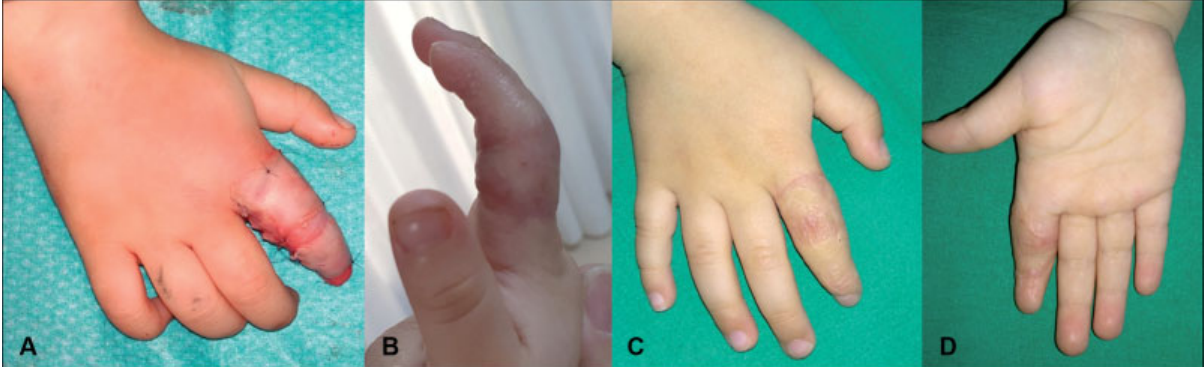
Fig. 2 Treatment of the sequelae. ( A ) Immediate postoperative result after surgical debridement of the burn on the dorsum of the fi nger and escharectomy of the ischemic eschar at the base and grafting with partial-thickness skin grafts. ( B ) Severe palmar contracture of the digit at 3 months follow-up. ( C ) Dorsum of handat 8monthsfollow-up, after surgically releasingthe contractureandgraftingwithfull-thickness skingraft. ( D ) Palm of